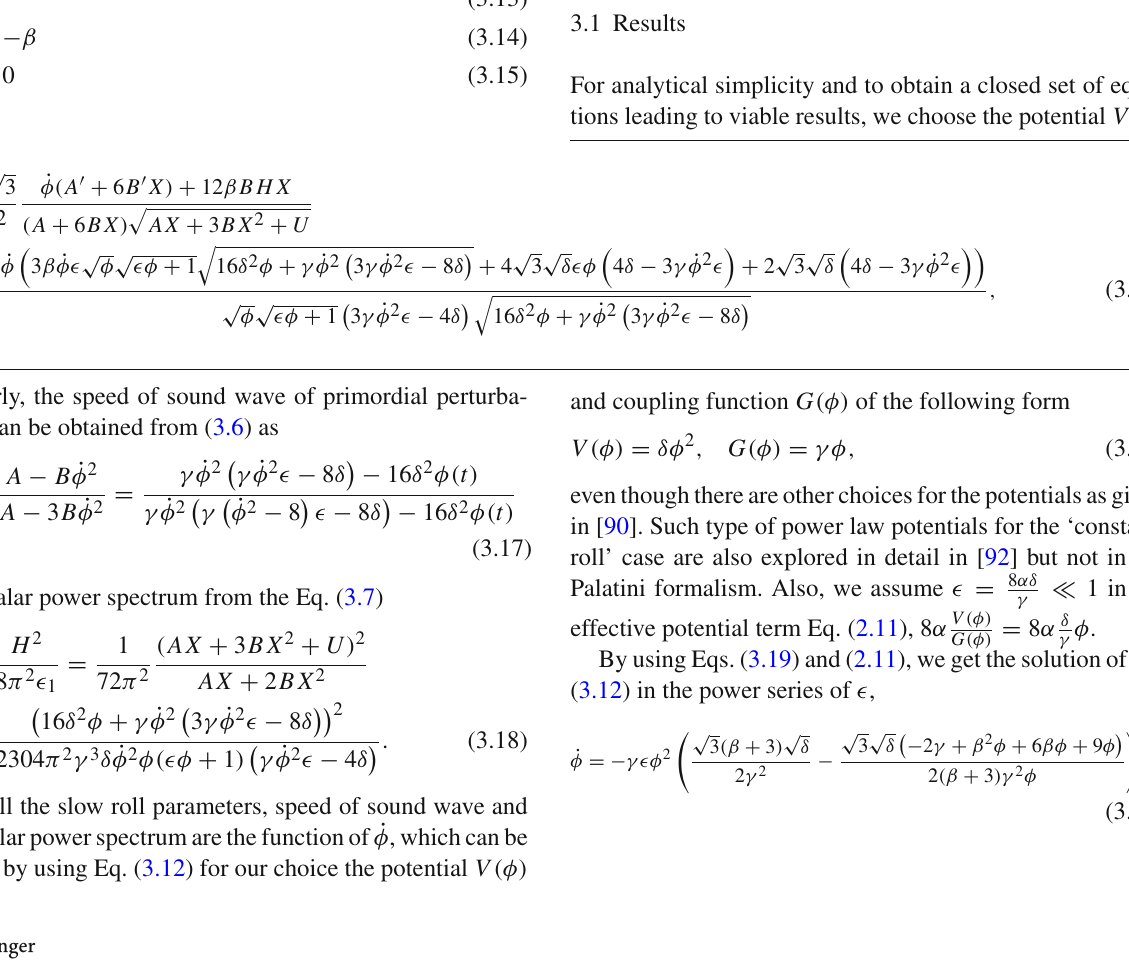
˙ φ can be substituted